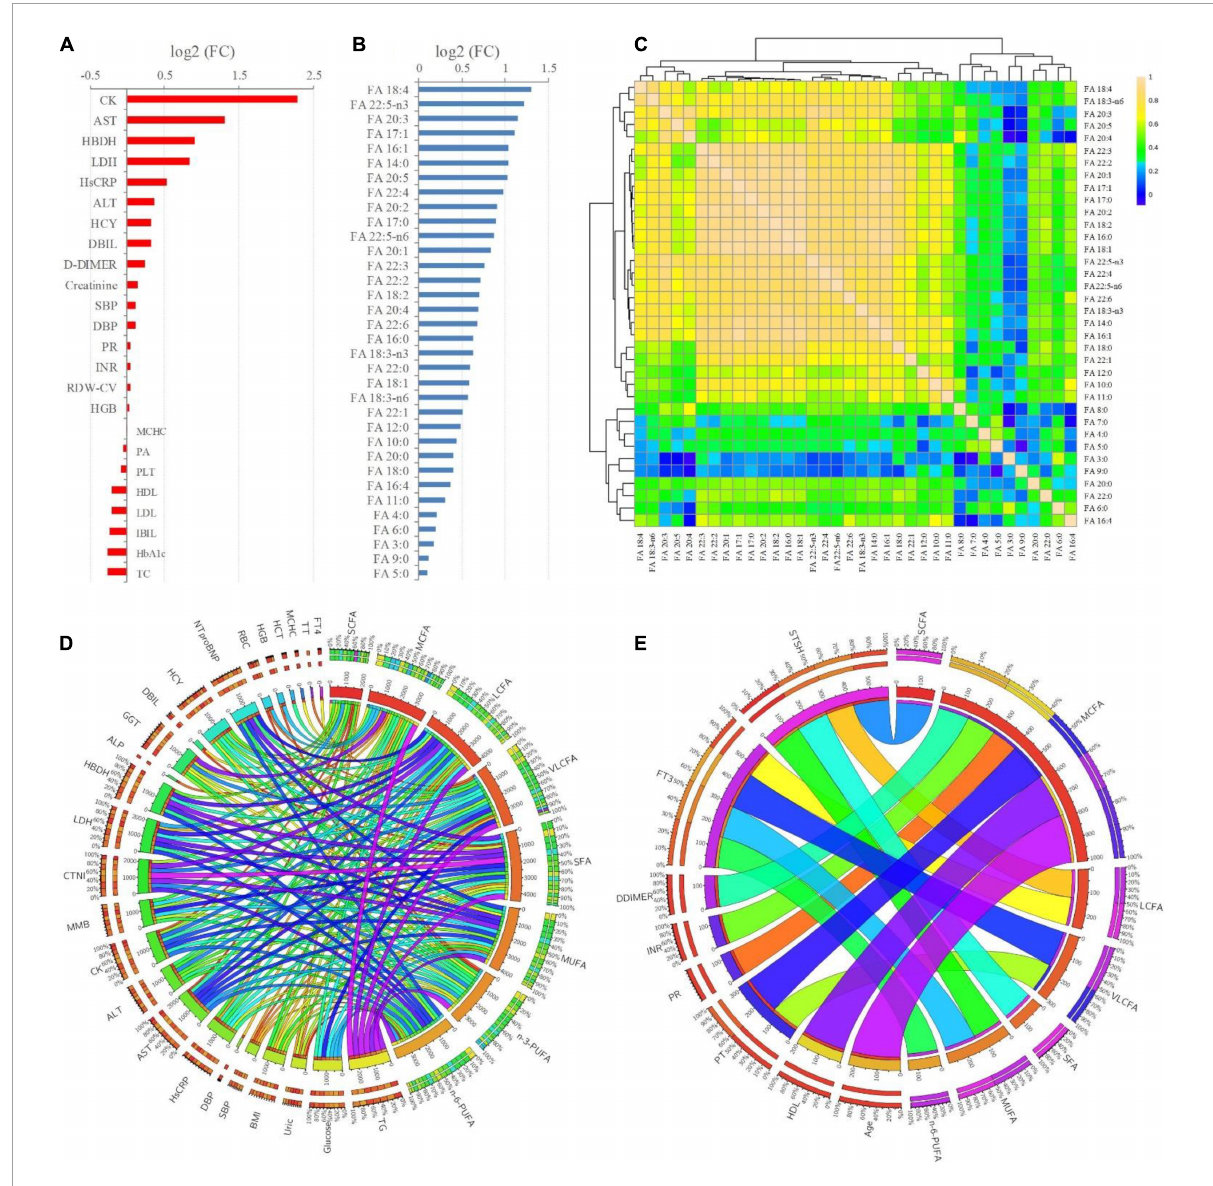
FIGURE3 (A,B) FCs (T2DM-CHD/T2DM) of the significantly changed ( P < 0.05) clinical indicators and FFAs existed between T2DM and T2DM-CHD groups, respectively. (C) Spearman’s rank correlation analysis of the FFAs. (D,E) Significant positive and negative correlations ( P < 0.05) existed between FFAs and clinical indictors,